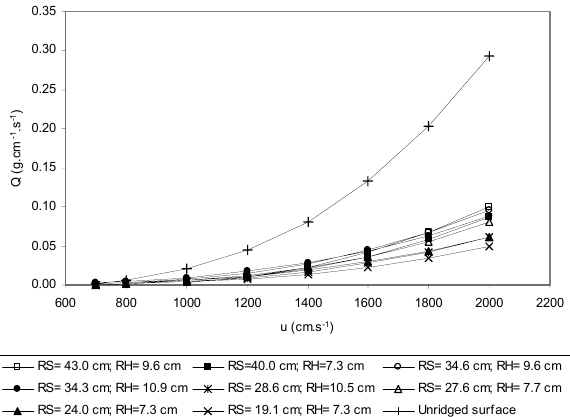
Fig. 10. Calculated erosion fluxes as a function of the wind velocity at 10m.